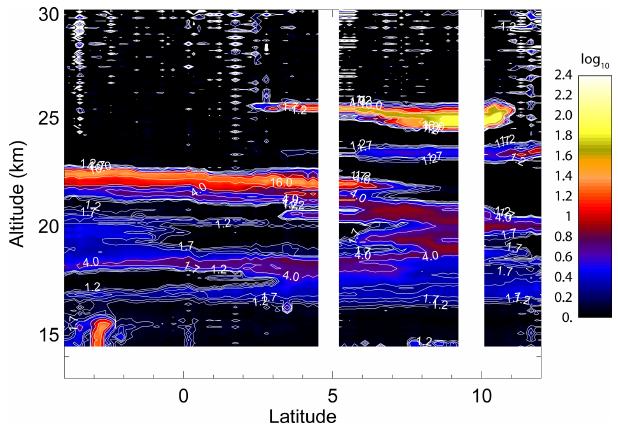
Figure 10. Aerosol backscatter ratio from the July 1991 airborne lidar mission aboard the NASA DC-8. Contours are at 1.2 (dark blue), 1.4, 1.7, 2, 4, 8, 16, 32, 64 (orange) with a highest observed value at 82 (yellow). Above 17km, all of the contours are associated with relatively fresh Pinatubo